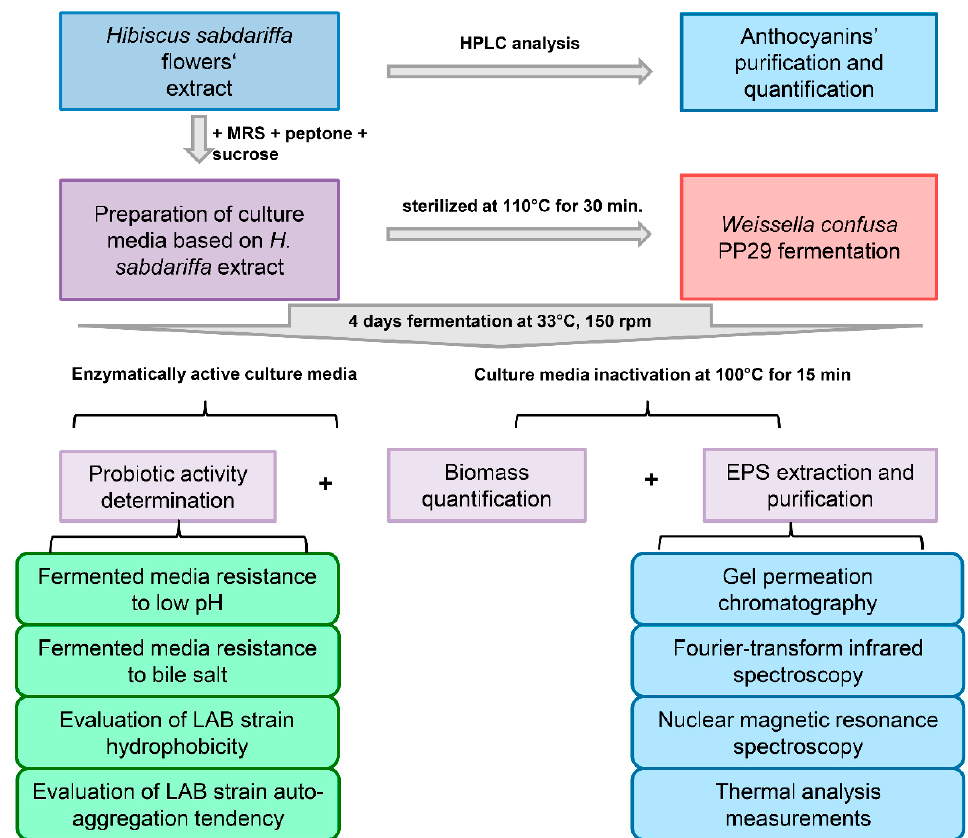
Scheme 1. Experimental flow and characterisation techniques used in order to demonstrate the experimental